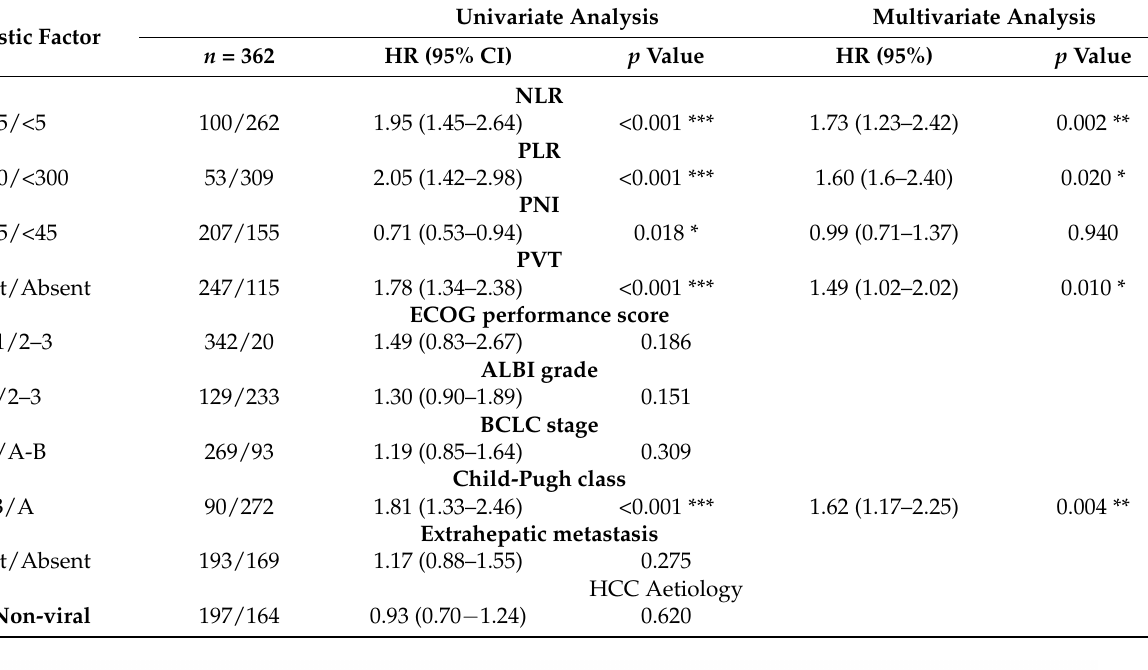
Table 3. Univariate and multivariate Cox regression model assessing for overall survival. NLR: neu-